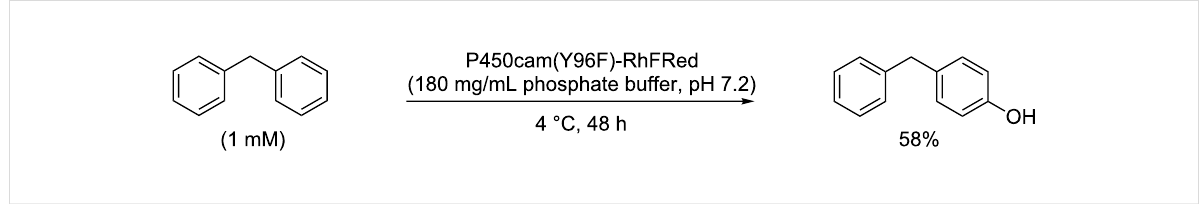
Scheme 1: Whole cell biotransformation of diphenylmethane to 4-hydroxydiphenylmethane with